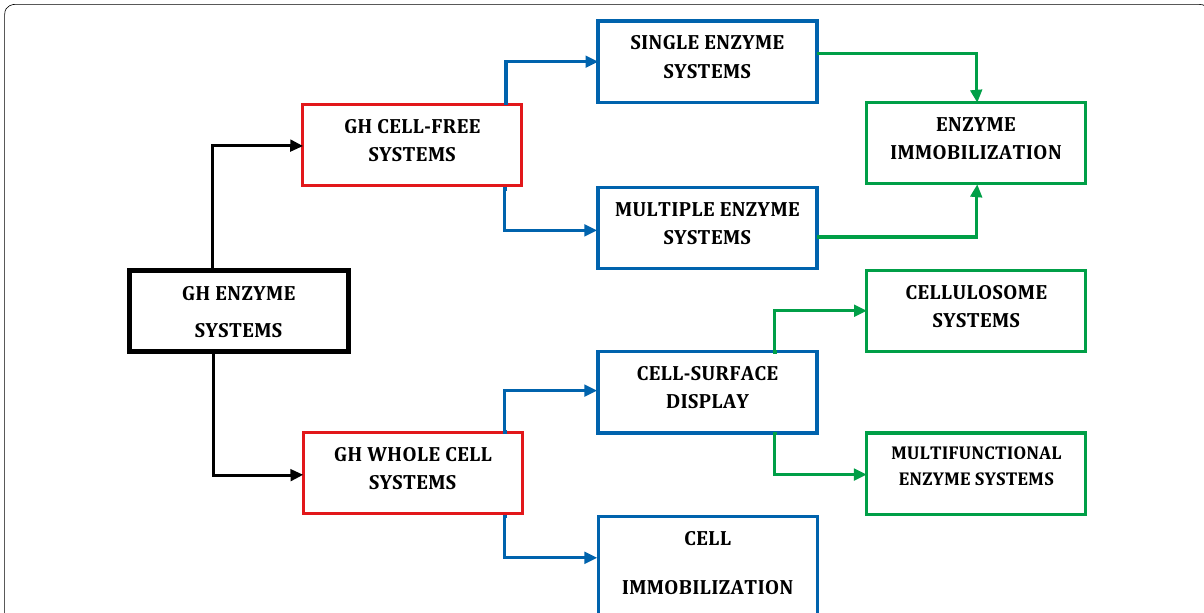
Fig. 3 Developments in GH systems. Pioneer systems in red ; systems under continual improvement in blue ; and emerging systems in green . The immobilization of both cell-free systems and whole-cell biocatalyst is